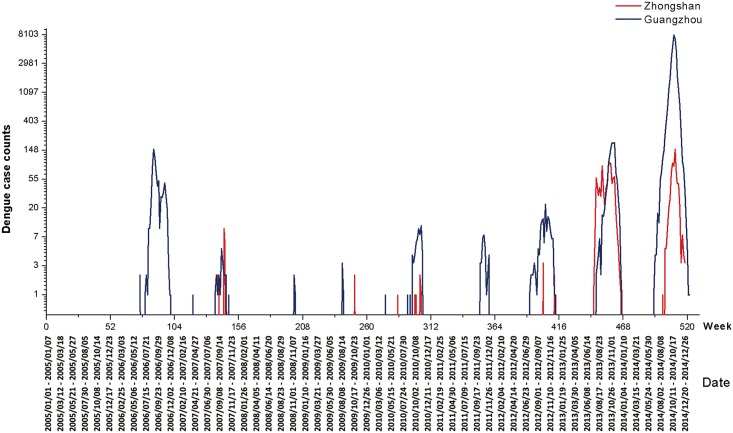
Weekly dengue case numbers in Zhongshan and Guangzhou, 2005 to 2014.* *: The Y axis is displayed in natural exponential scale.